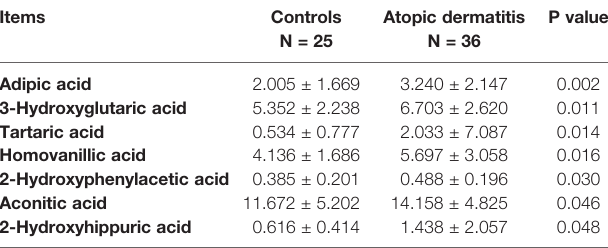
Atopic dermatitis P value N = 25 N = 36